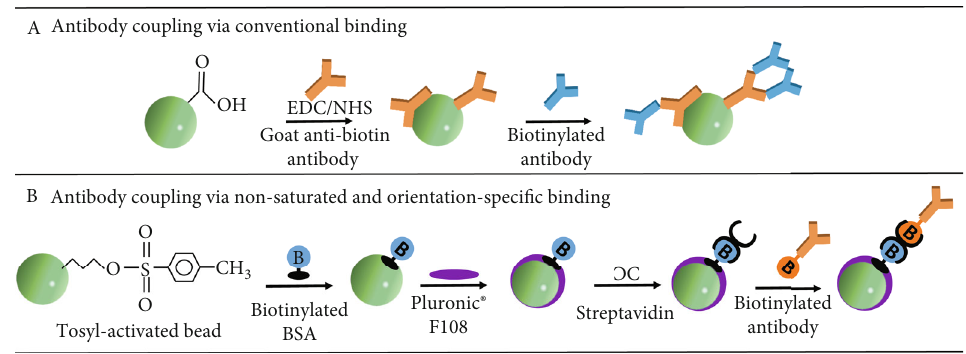
Figure 4: Antibody conjugation to the surface of the paramagnetic particle: (a) antibody conjugation using conventional antibody methods; (b) “ orientation-speci fi c ” antibody conjugation using Beckman Coulter ’ s 3-layer antibody coupling